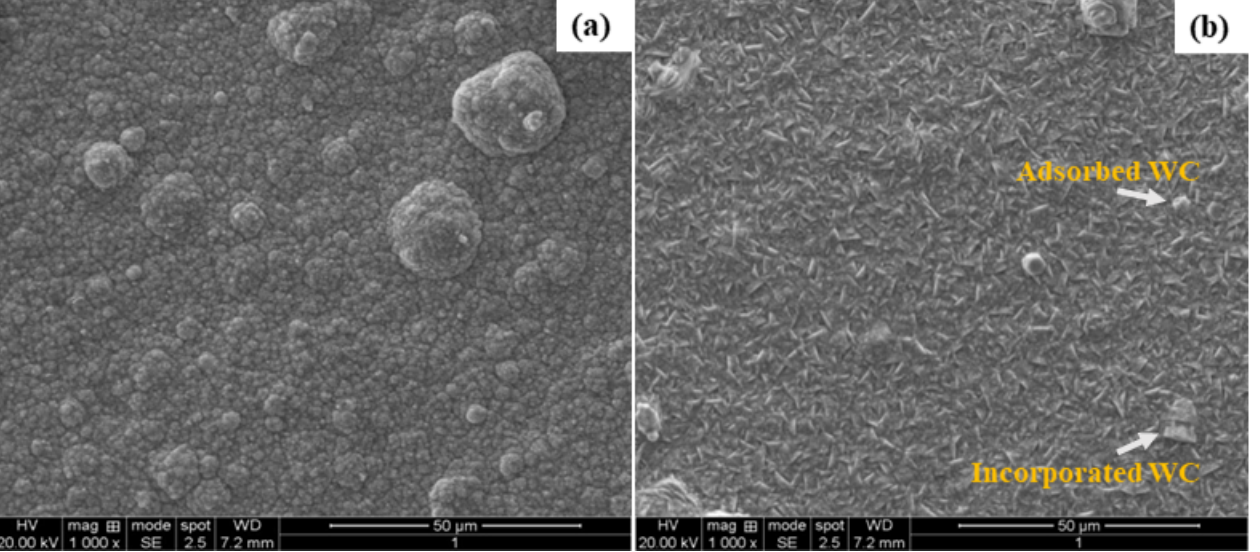
Figure 7. SEM morphology of coatings: ( a ) Zn–Ni alloy and ( b ) Zn–Ni–WC